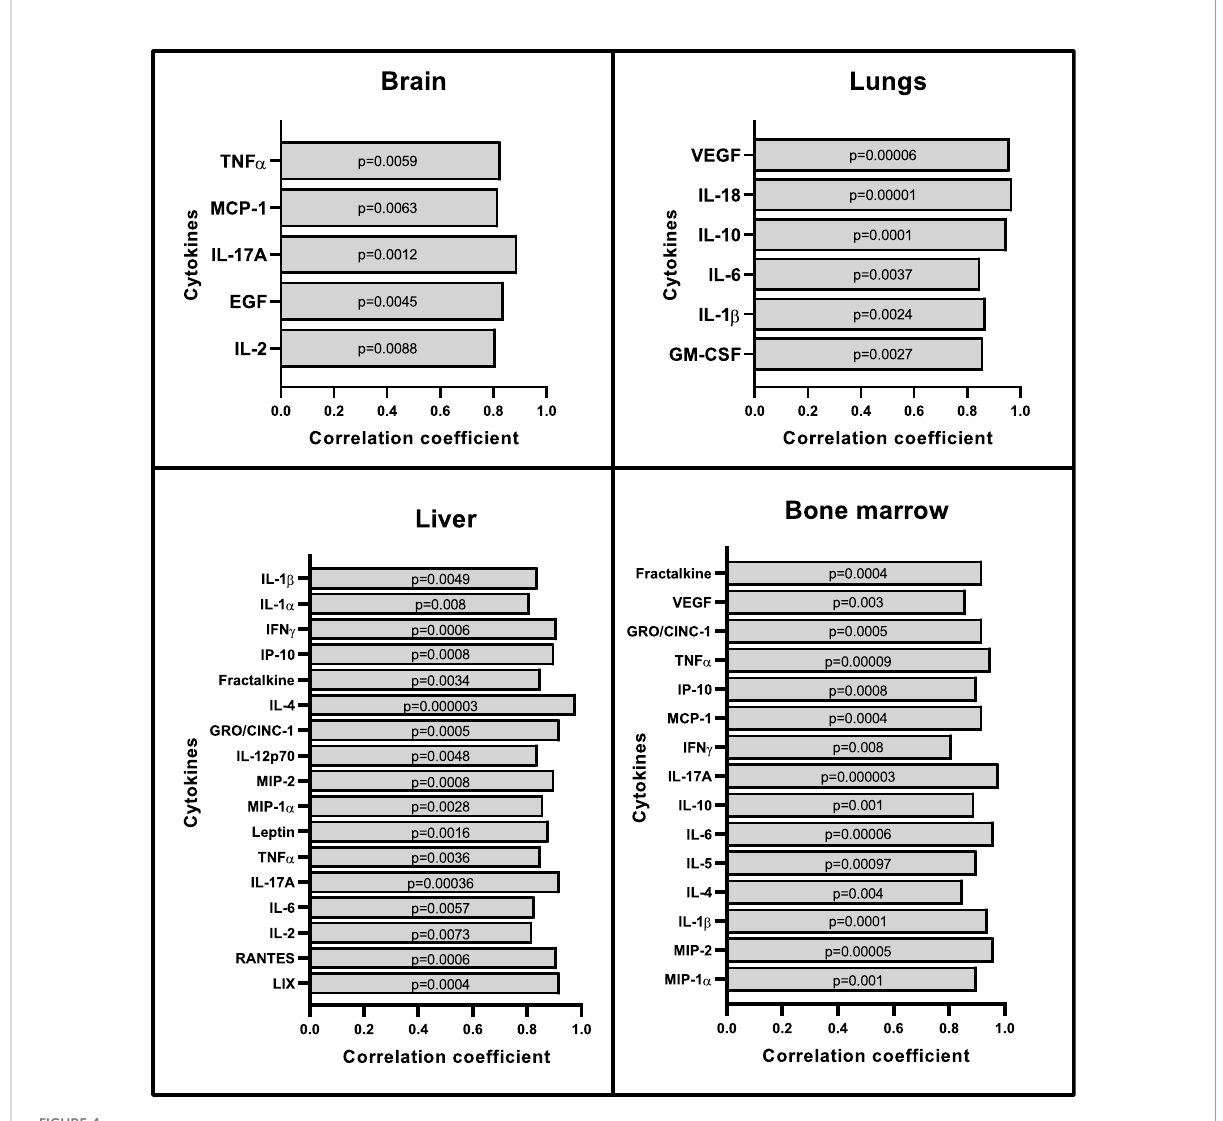
FIGURE 4 Correlation between organ SUV mean with serum cytokines and chemokines. Repeated measures correlations analysis shows positive correlations between cytokines in serum and SUV mean values from brain, lungs, liver, and bone marrow (n=8). No correlations were seen with the spleen. Statistical analysis was performed using the rmcorr package in R. In order to account for multiple comparisons in this analysis, correlations with p-values < 0.01 were considered to re fl ect positive or negative